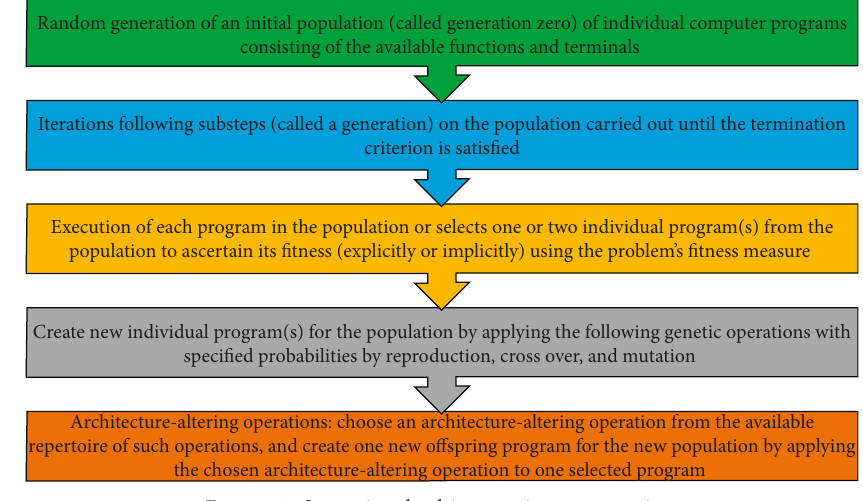
Figure 1: Stages involved in genetic programming. Table 1: Parameter setting for genetic